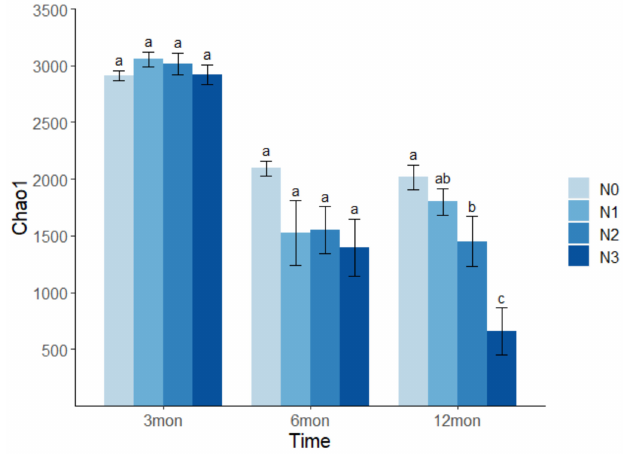
Figure 2. Effects of N deposition on soil bacterial chao1 index. Different letters indicate significant differences among treatments within the same sampling time ( p < 0.05,